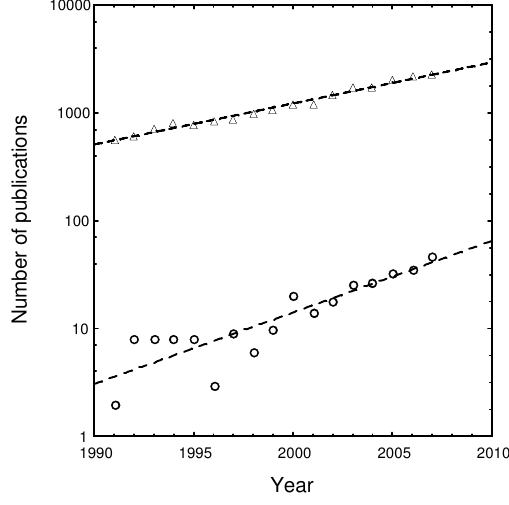
Figure 6. Trends in the total number of remote sensing papers ( (cid:1) ) and number of RS papers referring to policy (o) published between 1991 and 2007 as retrieved from ISI